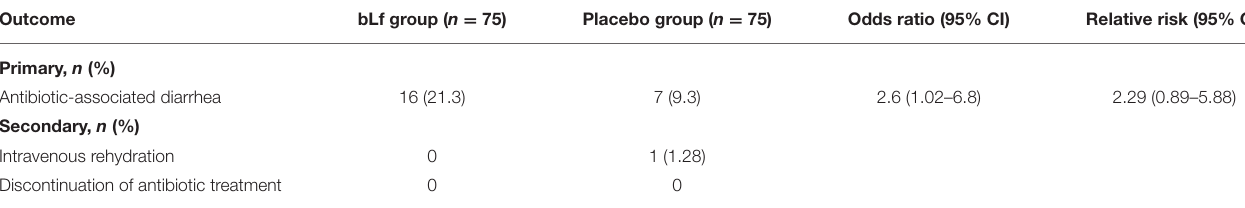
TABLE 2 | Primary and secondary outcome measures. Outcome